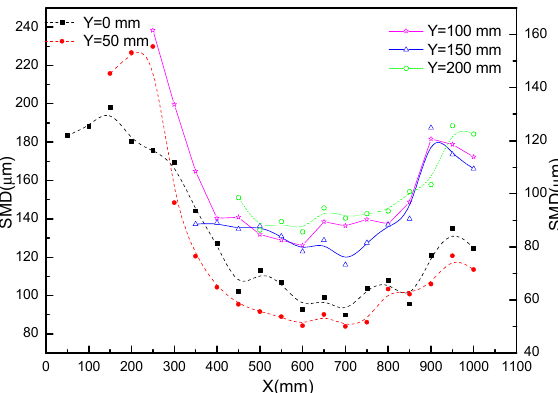
Figure 6. Comparison curves of the SMD distribution along the axial direction.